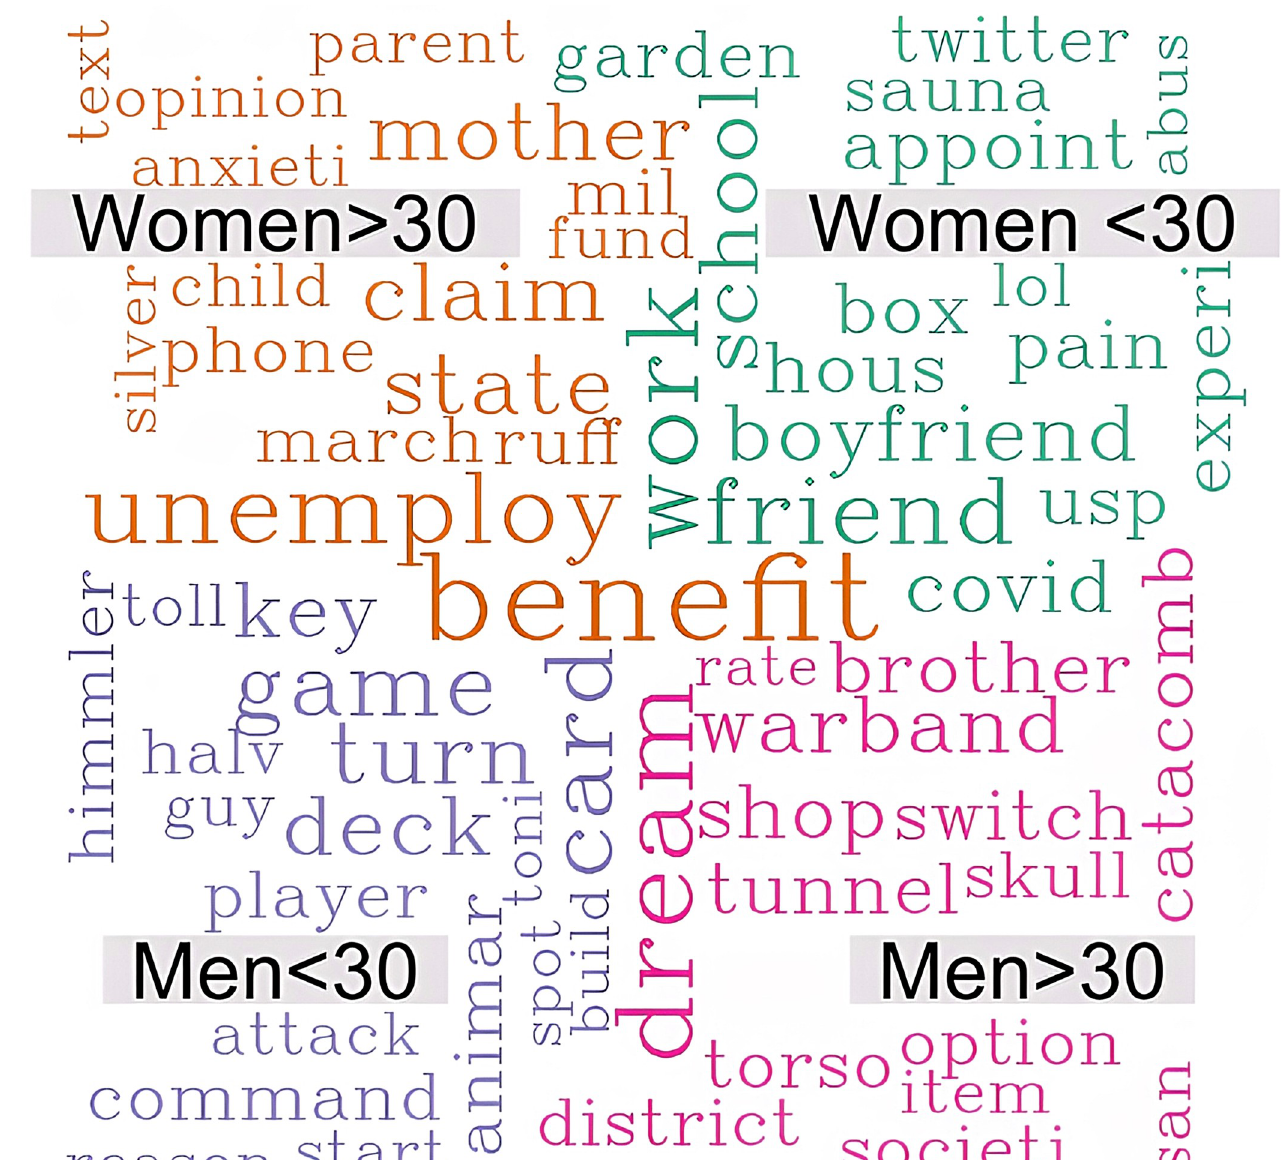
Fig 3. Word cloud to compare the most frequent words among the four groups.